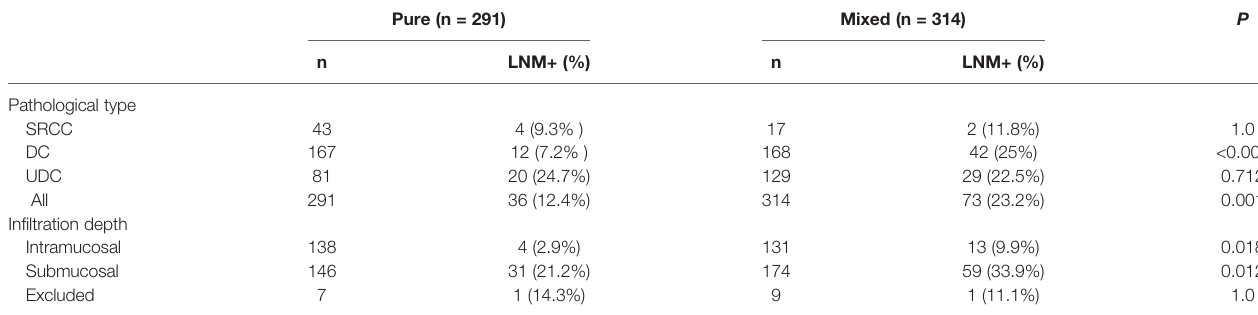
TABLE 5 | Lymph node metastasis in pure and mixed early gastric cancer.